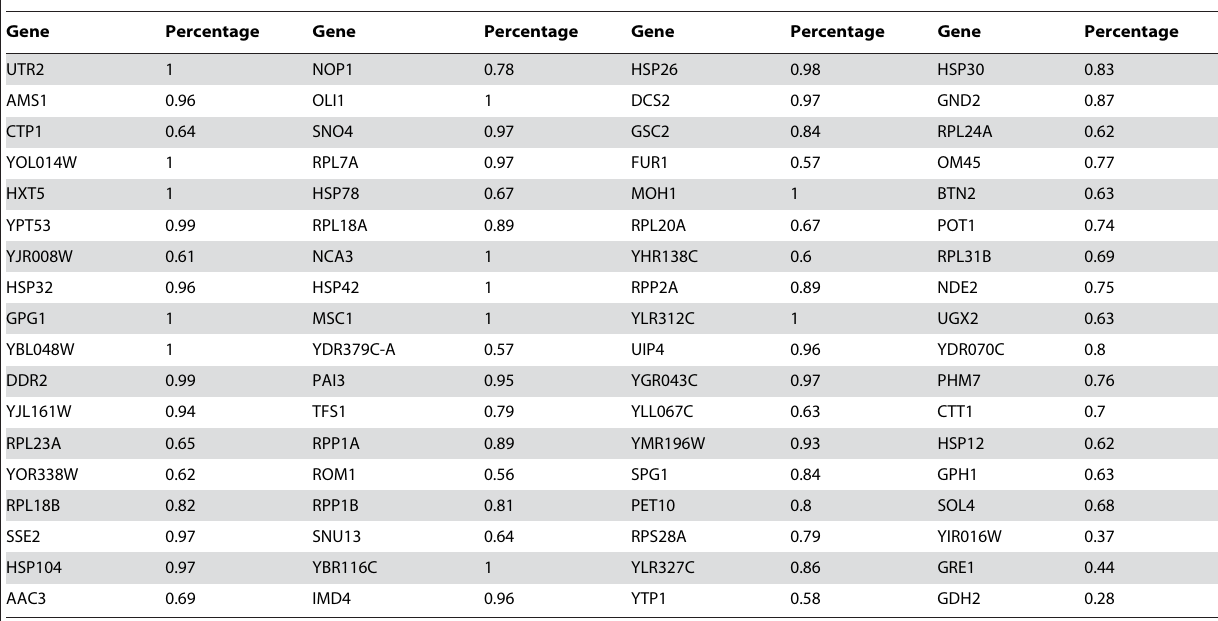
Table 2. Reliability study for the 72 growth-specific genes.